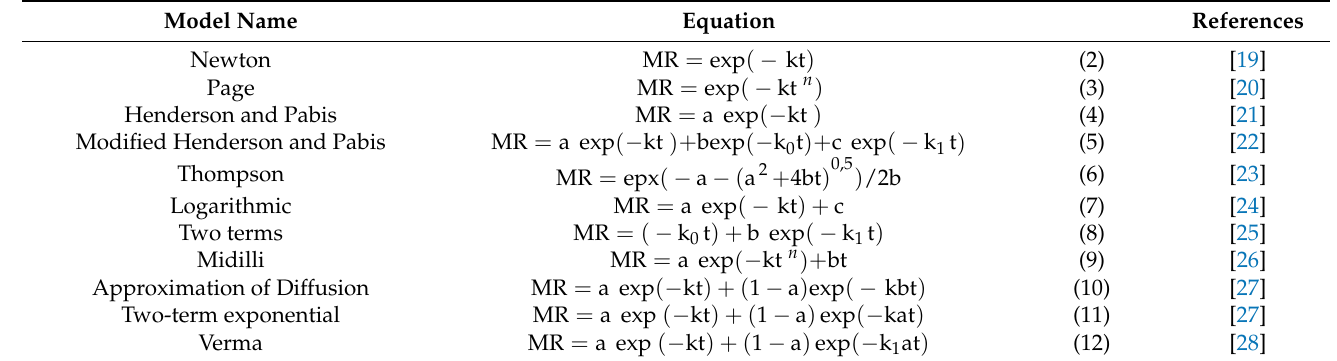
Table 1. Mathematical models used to estimate the drying kinetics curves of the faba